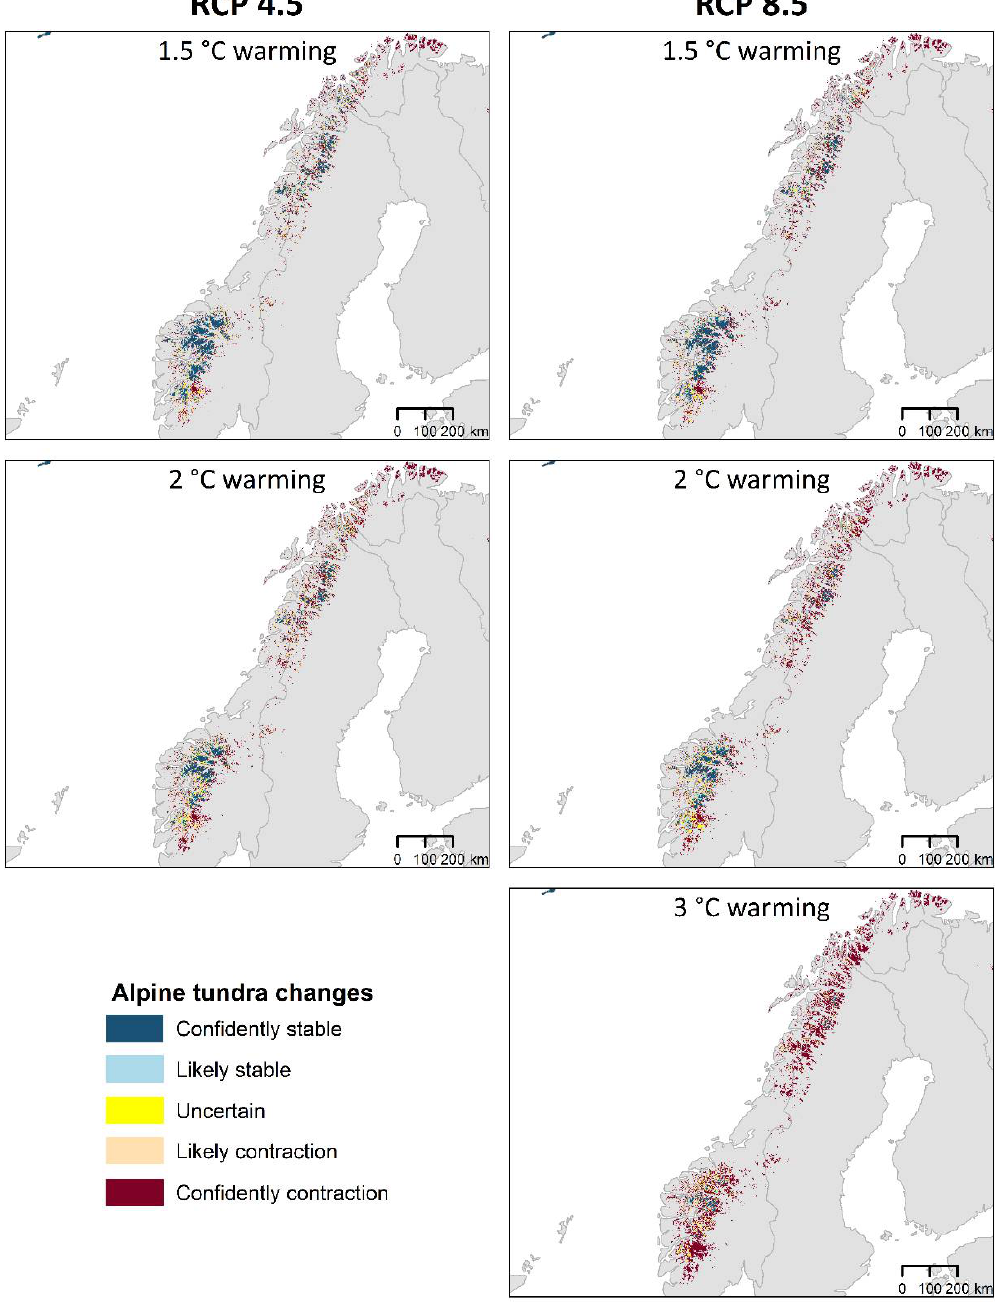
Figure 6. As for Figure 5 but for the Scandes.